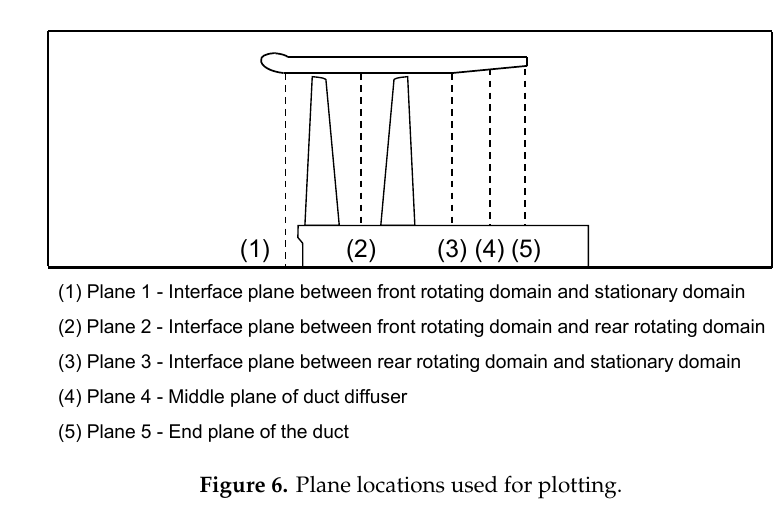
Figure 6. Plane locations used for plotting.